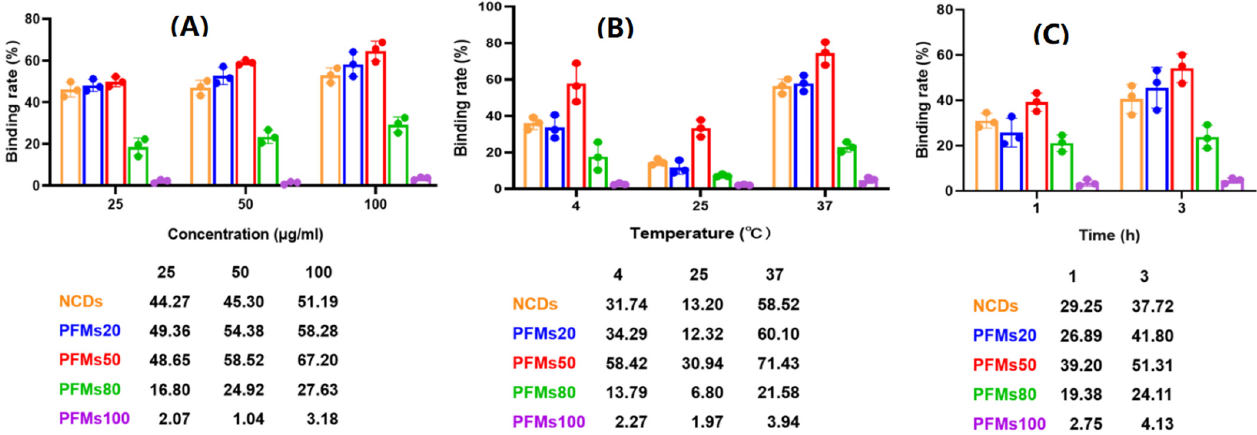
Figure 2. Optimization of permeability of the P. falciparum -infected erythrocytes with non- synchronized culture. Three factors are involved, including ( A ) concentration: 25, 50 and 100 µ g/mL; ( B ) temperature: 4 ◦ C, 25 ◦ C and 37 ◦ C, ( C ) incubation time: 1 h and 3 h. One factor was tested with the optimal conditions of other two factors. x -axis indicates incubation condition, y -axis indicates binding rate. The data below this chart showed specific binding rate of